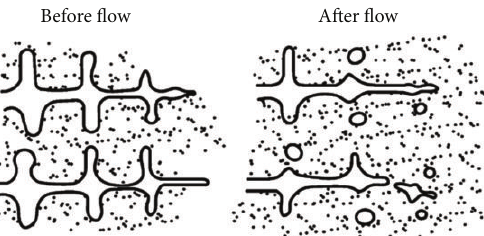
Figure 3: Schematic diagram of dendrite multiplication theory [15].